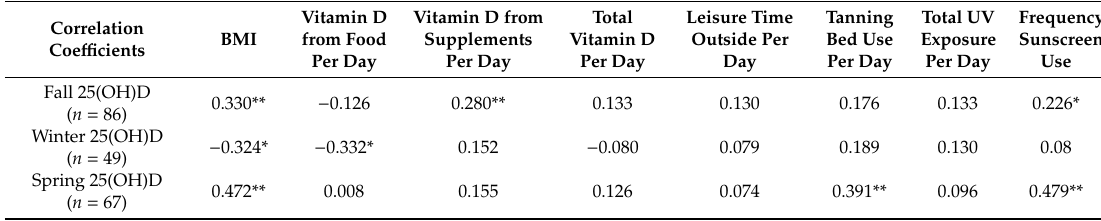
Table 2. Association Between Serum 25(OH)D Concentration and Body Mass Index (BMI), Vitamin D Intake, and Markers of Sun Exposure (Study 1).